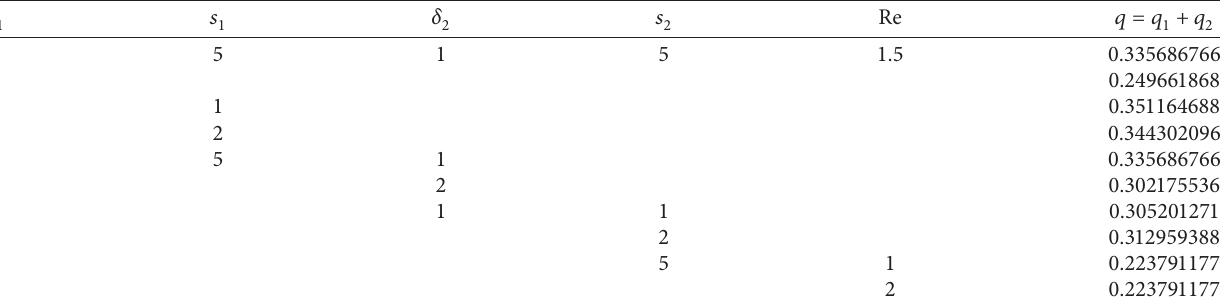
Table 3: The computation of volumetric flow